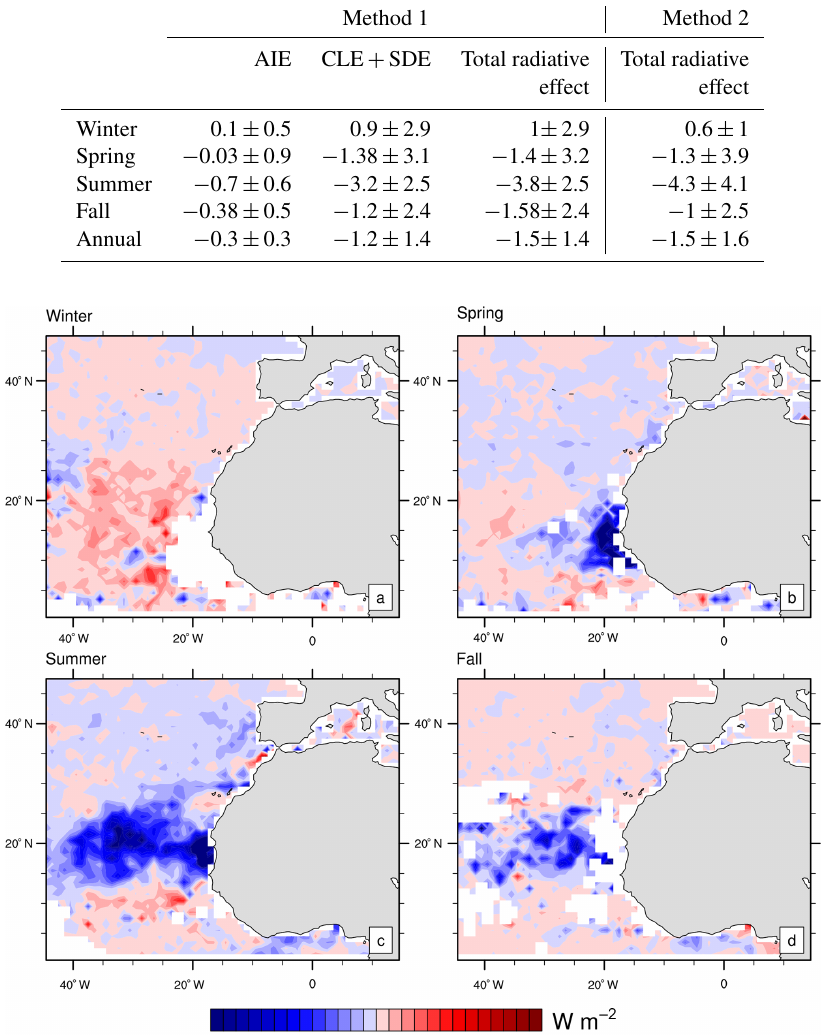
Figure 5. The second term of Method 1 (Quaas et al., 2008), which represents the cloud lifetime effect and semidirect effect of dust on marine stratocumulus clouds (Wm − 2 ) that includes CLE + SDE for (a) winter, (b) spring, (c) summer, and (d)